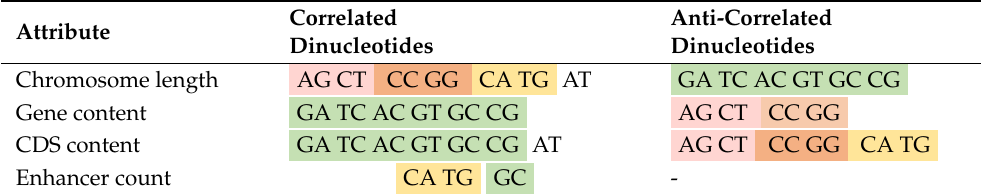
Table 1. Dinucleotides correlated or anti-correlated with attributes: lists of dinucleotides significantly correlated or anti-correlated with chromosome length, gene content, CDS content or enhancer count (see Section 2.3, Figure 3, Table S3). Re-occurring sets of dinucleotides are highlighted with different background